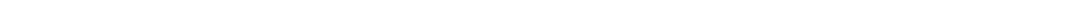
Fig. 7 The reshaped microbiota in Nlrp3 R258W mice resists gut in fl ammation through boosting local Tregs. a Colonic lamina propria cells were isolated from either cohoused or singly housed WT/ Nlrp3 R258W mice, intracellular Foxp3 level from CD4 + T cells was analyzed through fl ow cytometry. The representative samples were shown and the percentage of Foxp3 + cells in CD4 + T cells was summarized. The data are shown as the means ± SEM, * P < 0.05, ** P < 0.01, *** P < 0.001 (repeated measures ANOVA with Dunnett ’ s post-hoc test). b Feces from the WT and Nlrp3 R258W mice were transplanted to germ-free WT mice (Gnoto-+/+, n = 10, Gnoto-+/R258W, n = 11), colonic lamina propria cells were isolated and intracellular Foxp3 level from CD4 + T cells was analyzed through fl ow cytometry. The representative samples were shown and the percentage of Foxp3 + cells in CD4 + T cells was summarized. The data are shown as the means ± SEM, * P < 0.05 (two-tailed Student ’ s t test) c Colonic lamina propria cells were isolated from WT, Nlrp3 R258W , Nlrp3 R258W x Il1r1 − / − , and Il1r1 − / − mice, intracellular Foxp3 level from CD4 + T cells was analyzed through fl ow cytometry. The representative samples were shown and the percentage of Foxp3 + cells in CD4 + T cells was summarized. The data are shown as the means ± SEM, * P < 0.05, ** P < 0.01 (one-way ANOVA with Tukey ’ s post-hoc test). d , e WT untreated mice ( n = 5), Nlrp3 R258W mice i.p. injected with isotype antibody ( n = 4) and Nlrp3 R258W mice i.p. injected with anti-CD25 antibody ( n = 6) on day − 4 and day − 2 with 500 µ g/mouse/injection were subjected for colitis induction with 4% DSS from day 0. The body weights ( d ) and disease scores ( e ) were assessed daily. Data are shown as the means ± SEM. * P < 0.05, ** P < 0.01 (two-tailed Student ’ s t